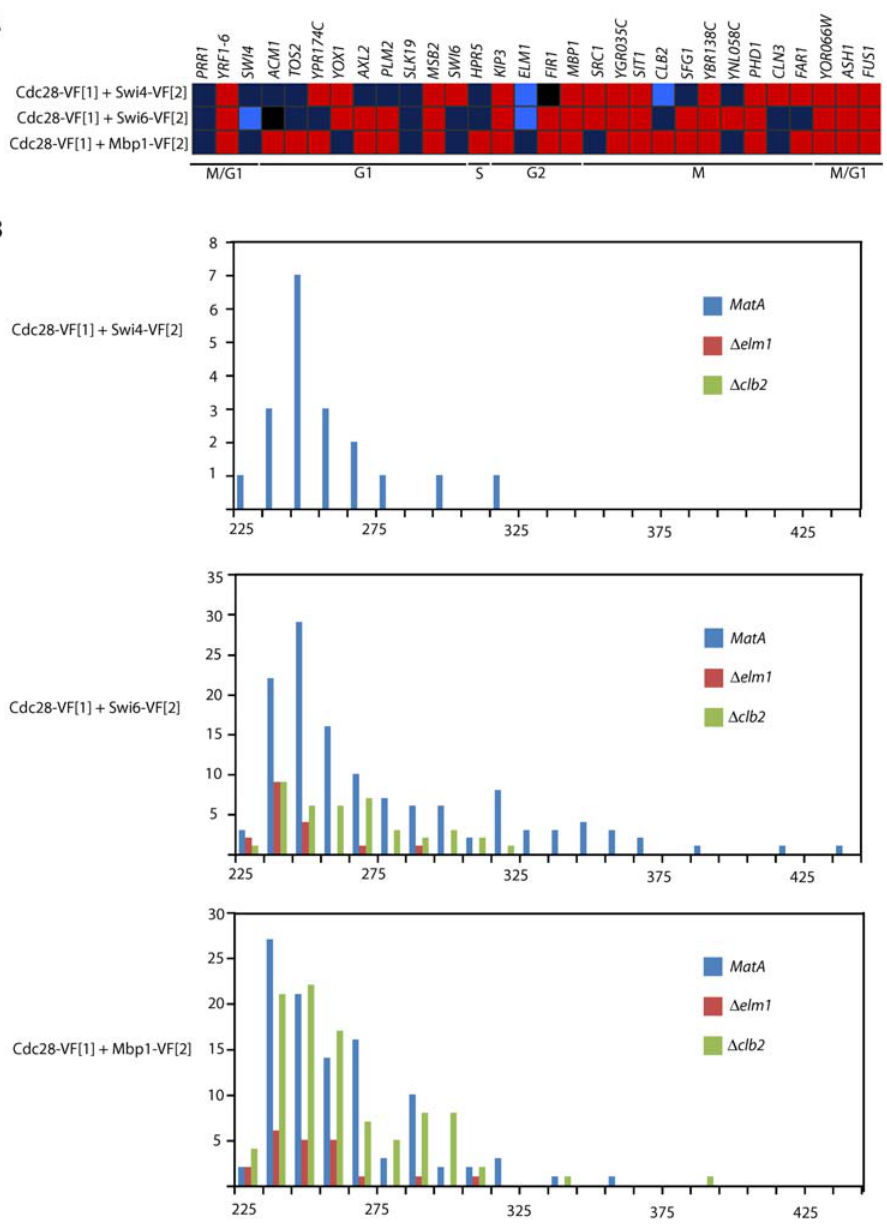
Figure 3. The GePPI screen identifies Elm1 as involved in the regulation of SBF by Cdc28. (A) Changes in average mean pixel intensity for the three PCAs: Cdc28-Swi4, Cdc28-Swi6 and Cdc28-Mbp1, in the 30 deletion strains. Dark red indicates increase in PCA signal, dark blue indicates decrease in PCA signal, and black represents no change in PCA signal in a deletion strain relative to MatA . Light blue indicates significant decreases in signal ( P , 0.0017). Genes are ordered according to time of peak expression during the cell cycle according to de Lichtenberg et al . [5] and the cell cycle phase of expression is indicated. (B) Representative histograms showing cell population distributions of fluorescent intensity for the three PCAs used in this study in Mat A , D elm1 and D clb2